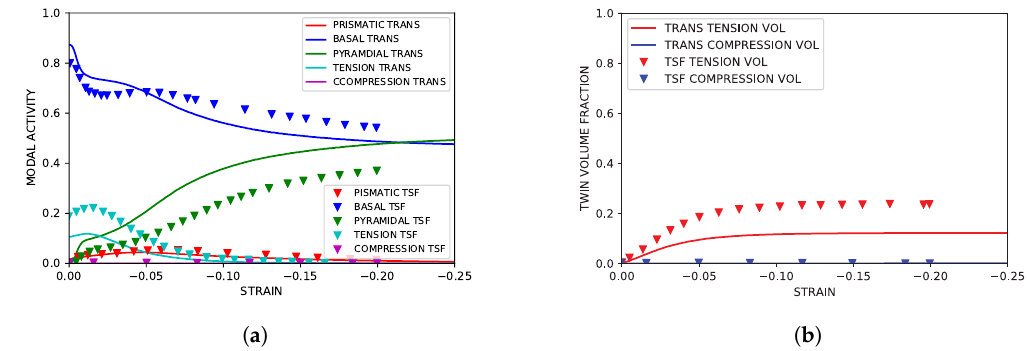
Figure 4. Simulated slip and twinning activity under TTC compression compared to simulated results from Oppedal et al. [14]. ( a ) Simulated modal contributions vs. strain. ( b ) Simulated twin volume growth vs.